Question: Sum up the contents of this chart in one sentence.
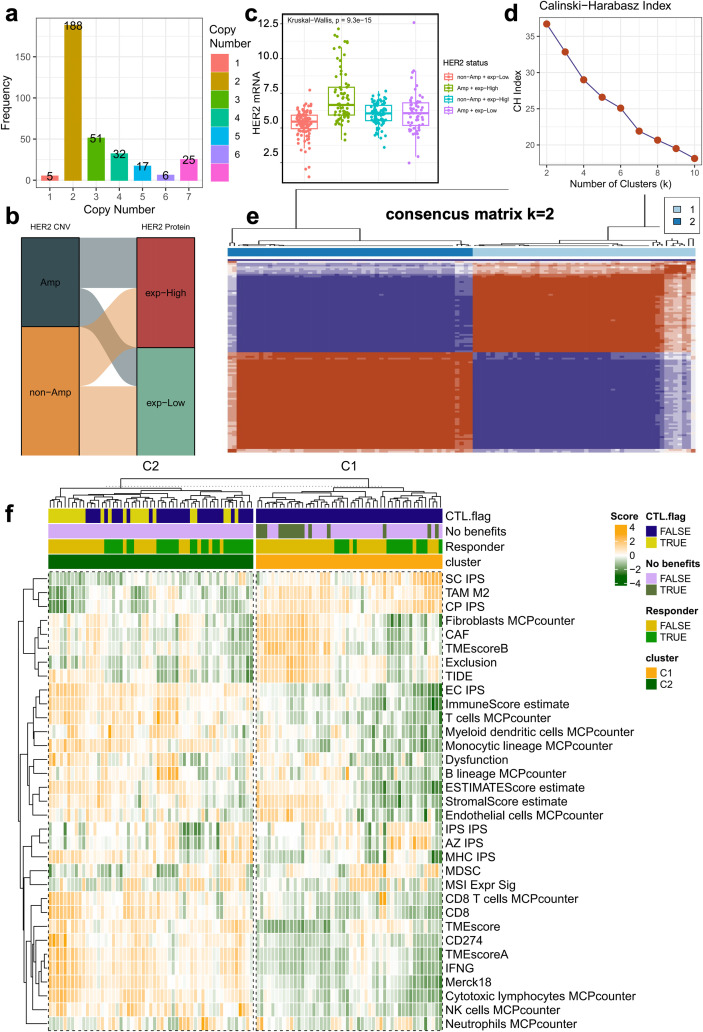
Answer: Screening and immunophenotyping of HER2-negative samples. This study illustrates (A) the frequency distribution of HER2 copy numbers in the cohort, (B) the correspondence between HER2 copy number variations (CNV) and protein expression levels, (C) a comparison of HER2 mRNA expression across different HER2 status subgroups, (D) the determination of the optimal cluster number using the Calinski-Harabasz Index, (E) the consensus clustering matrix for k=2, and (F) the landscape of immune-related signatures, tumor microenvironment (TME) infiltration, and clinical response markers across the two identified clusters (C1 and C2).